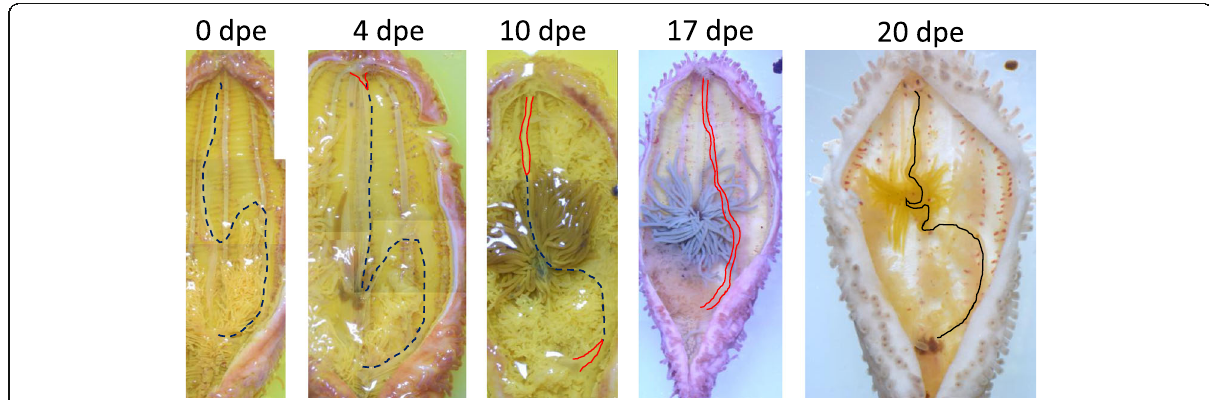
Fig. 2 Internal morphology of regenerating animals. Animals just after evisceration (0 dpe) to 20 dpe were dissected along the body length, at the right side of the mid-ventral ambulacrum and flattened. There are slight color variations of the animals, but specimens at 0, 4, and 10 dpe were fixed with Bouin ’ s fixative and thus appear yellowish. The animals were about 4 – 5cm in length. Black broken line: the edge of mesentery; red solid line: area along the edge of the mesentery, with thickened gut rudiments; black line: grown gut rudiment observable without the